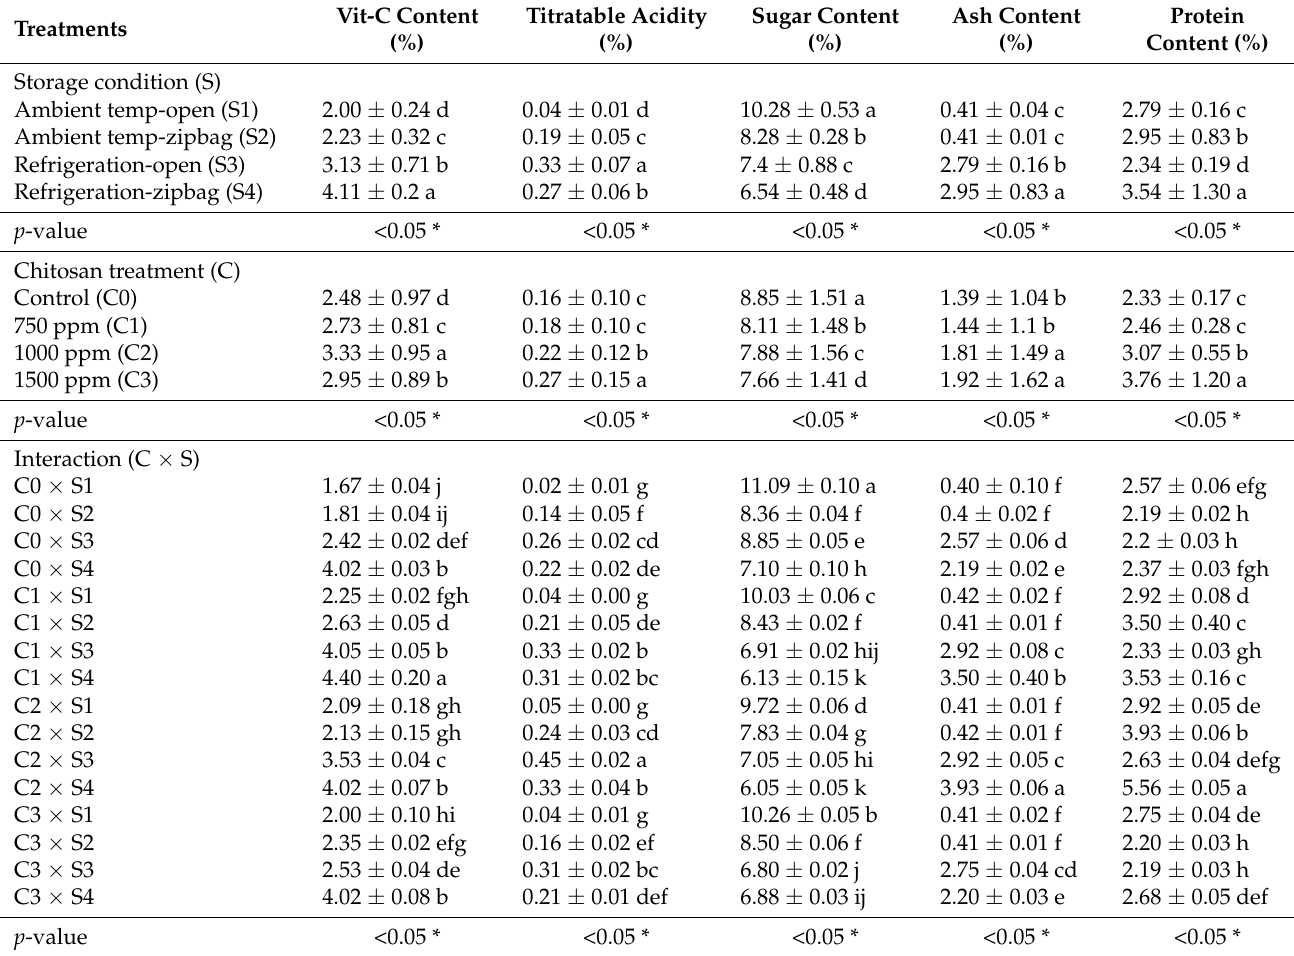
Table 1. Vitamin C, titratable acidity, sugar, ash, and protein content of chitosan-treated and